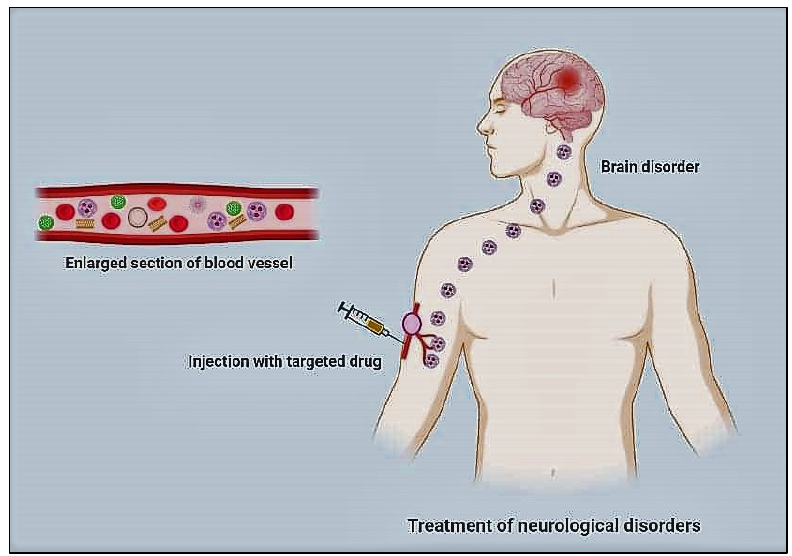
Figure 1. Schematic illustration of drug delivery system for the treatment of neurological disorders .